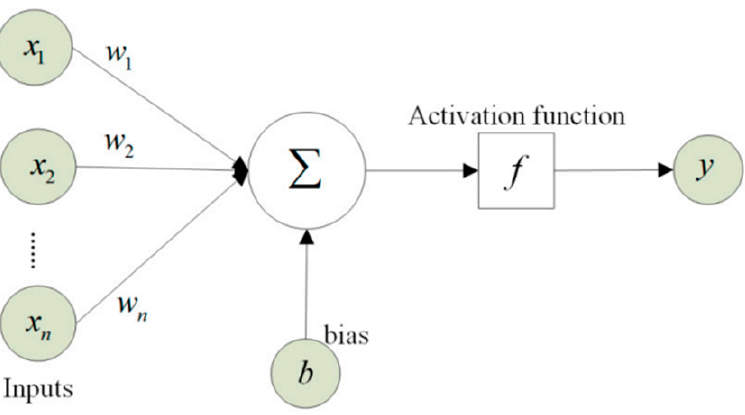
Figure 3. Basic structure of ANN neuron [38].